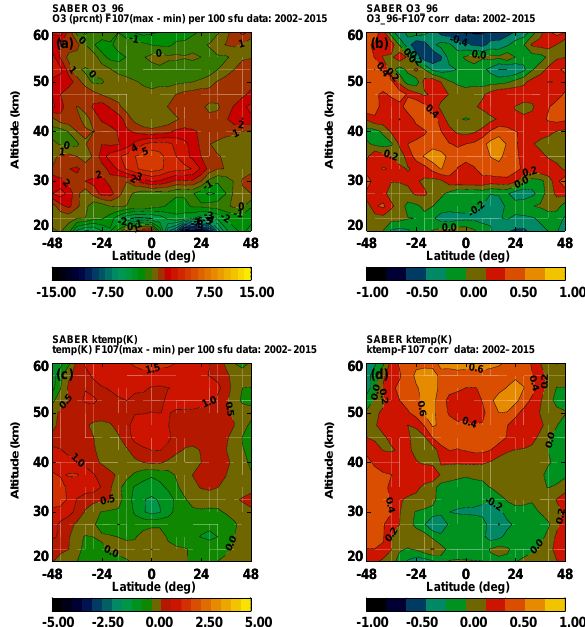
Figure 2. Ozone and temperature responses to solar variability on altitude (20–60km) vs. latitude (48 ◦ S to 48 ◦ N) coordinates, found by multiple regression. Top row left: ozone responses at solar max– ozone responses at solar min (%100sfu − 1 ); right panel: correlation coefficients between ozone mixing ratios and 10.7cm flux. Bottom row: as in top row but for temperature (K). Brown–green borders denote zero contours, with brown areas denoting positive